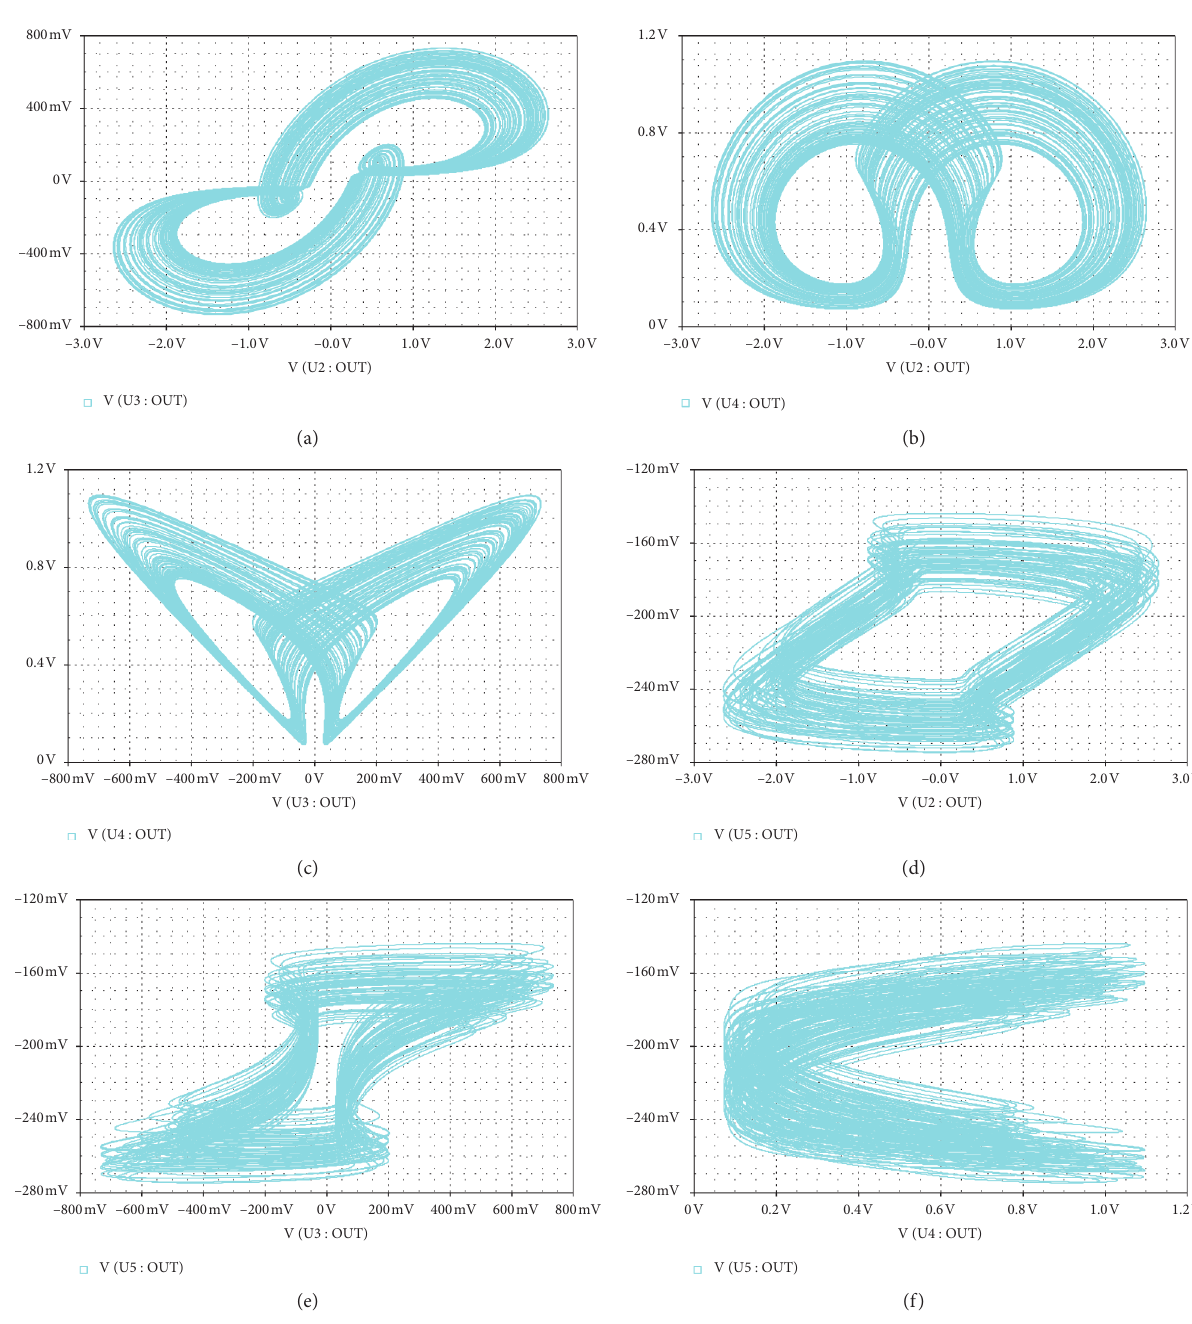
Figure 16: PSpice simulated phase portraits of chaotic attractors with initial voltages ( 1 V , 0 . 1V , 0V , 0V )